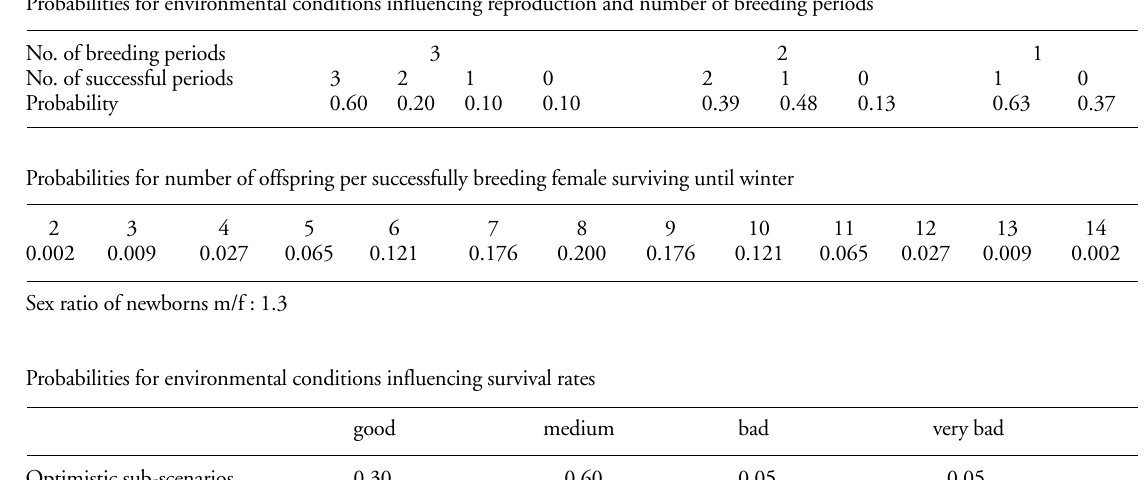
Optimistic sub-scenarios Pessimistic sub-scenarios Probabilities for annual age-dependent survival rates for different sites and environmental conditions, basic